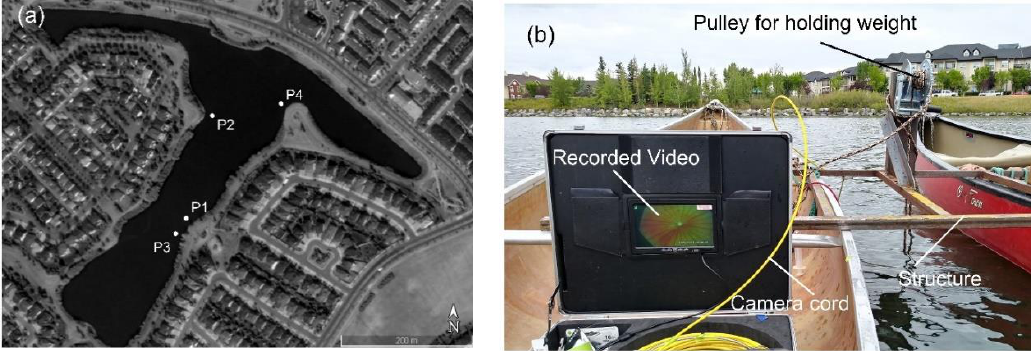
Figure 2. ( a ) Data collection locations in the Inverness pond (background photo extracted from Google